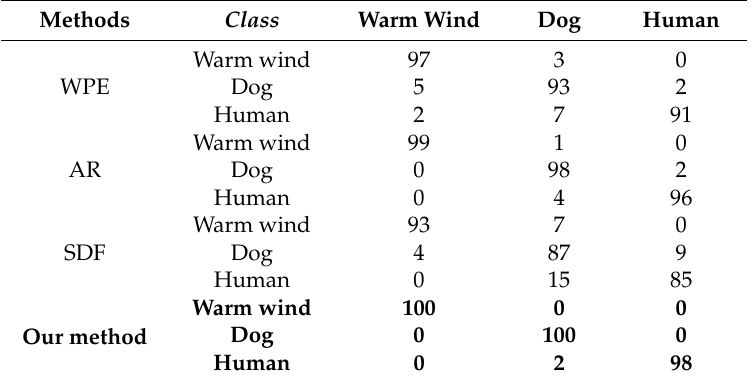
Table 4. Recognition results of each method in the experiments executed on Database